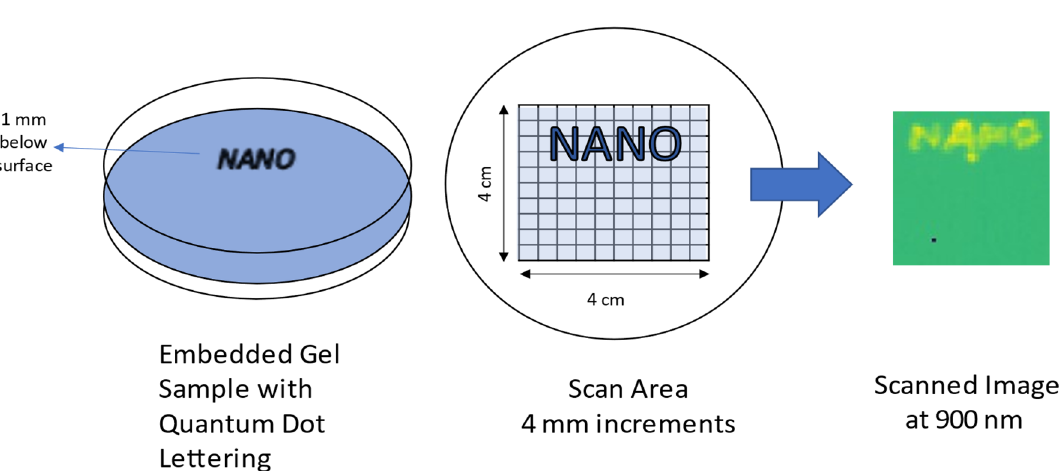
Figure 6. Embedded quantum dot gel sample and scanning scheme for demonstrating the ability to resolve at millimeter scale. The scanned image shown here is the slice collected at 900 nm and the CCD images at each scan position are summed without radial binning at each point to create the resulting image on the